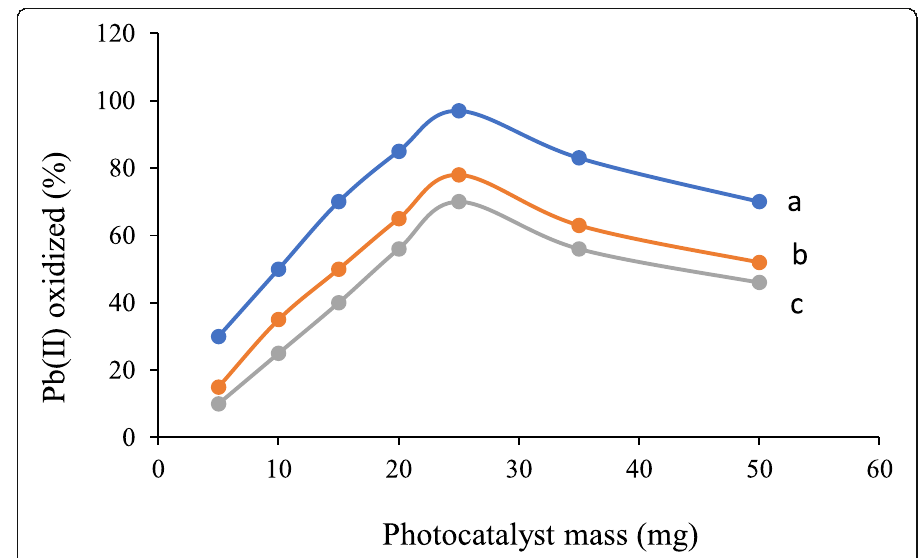
Fig. 5 Influence of the photocatalyst mass on the photo-oxidation over: a TiO 2 -N,S (1:1:1), b TiO 2 -N (1:1), and c TiO